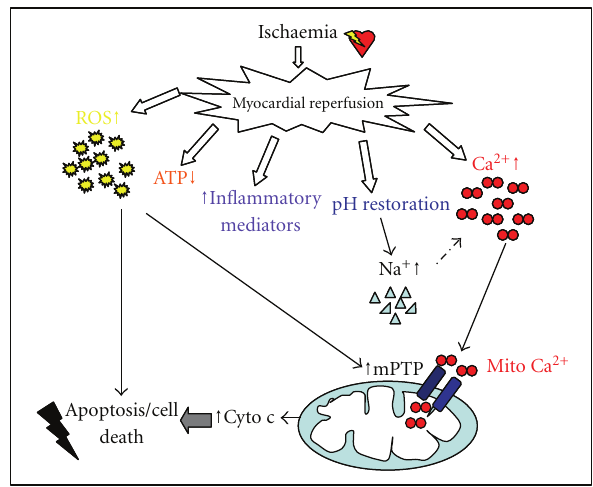
Figure 1: Endogenous factors contributing to ischemia-reperfusion injury. Following ischemia, blood flow is reestablished in the myocardium. The myocardium is subject to a number of abrupt changes during the transition from ischemia to reperfusion. Both biochemical and metabolic alterations occur including the generation of reactive oxygen species (ROS), decrease in ATP levels, an increase in inflammatory mediators, the rapid restoration of physiological pH, which in turn increases intracellular sodium and overload of intracellular calcium and mitochondrial calcium. These factors interact with each other to mediate reperfusion injury through the opening of the mitochondrial permeability